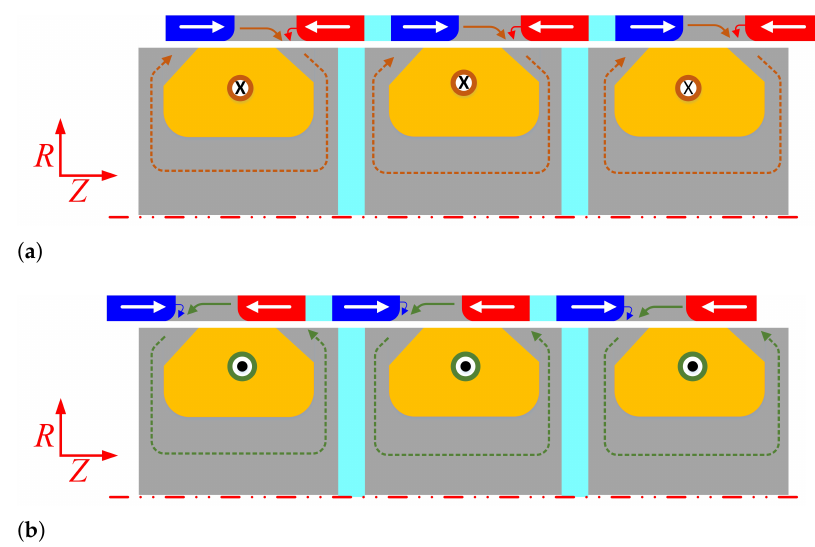
Figure 3. Mover position at: ( a ) positive z axis; and ( b ) negative z axis.